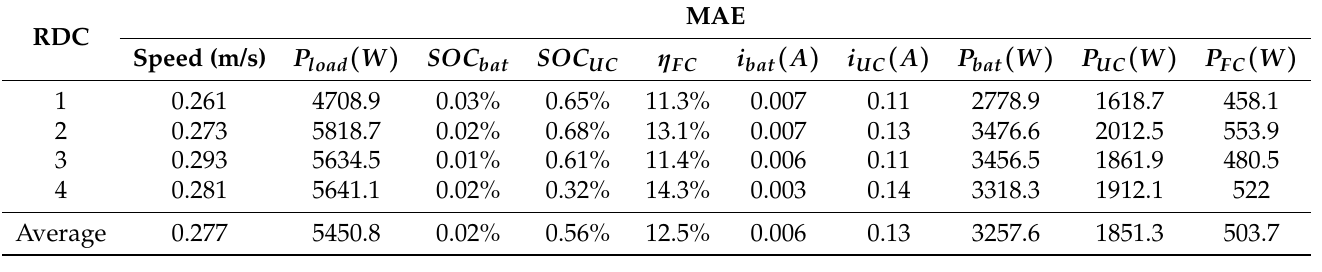
Table 10. Model results with prediction step.